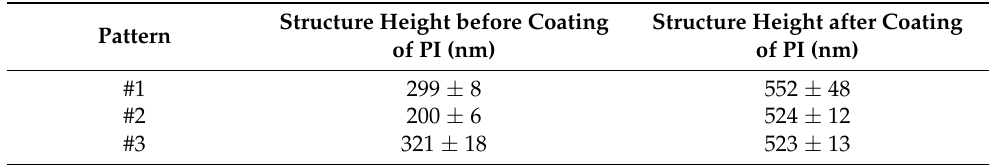
Table A3. Structure height of the surface reliefs for line pattern (#1), square pattern (#2), and check- board pattern (#3) used for LC cells in the polymer-free design. Pattern Structure Height before Coating of PI (nm) Structure Height after Coating of PI (nm)